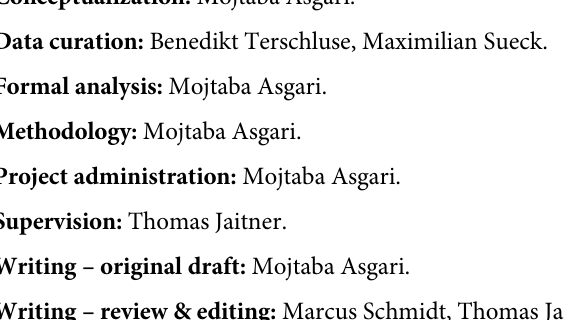
S1 Table. Mean values, standard deviation (SD) and mean standard error (mean SE) for the 11+ and